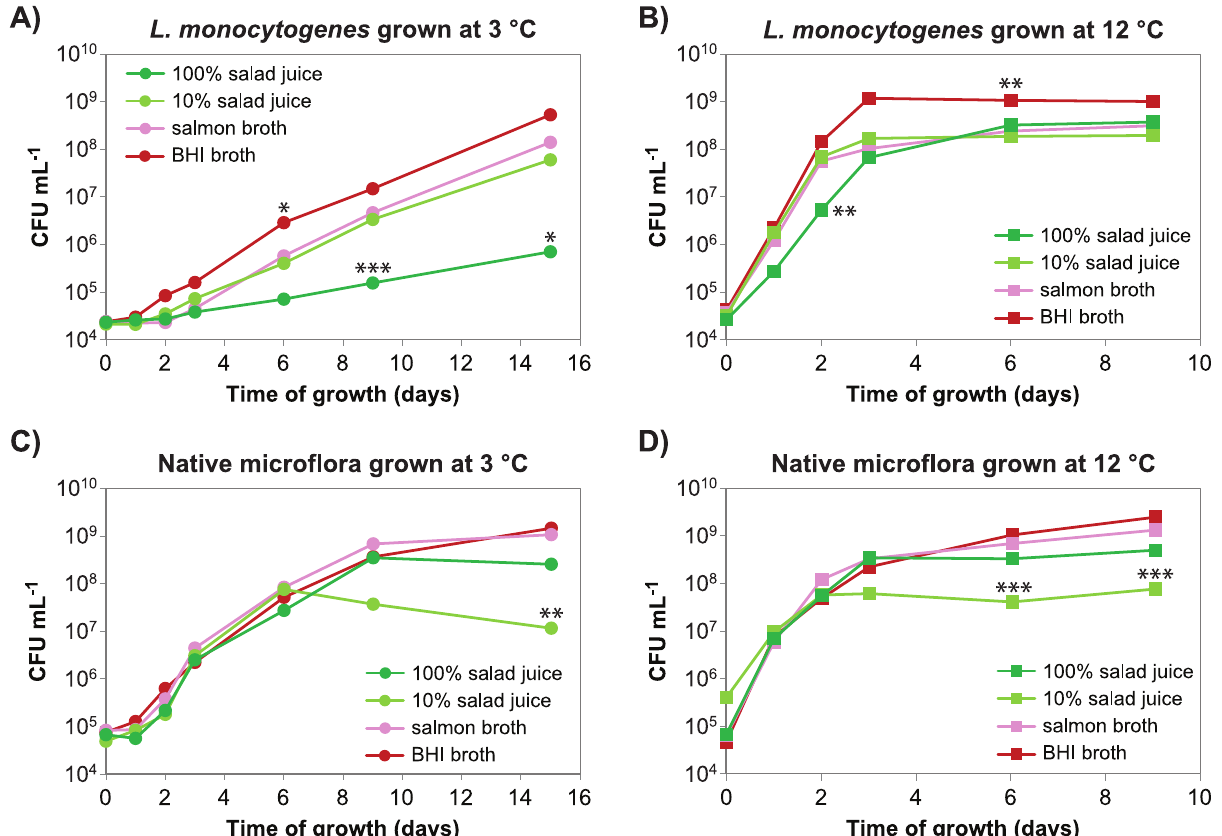
Fig 1. Salad juice inhibits growth of L . monocytogenes . The salad juice was prepared from a 1:4 (w/w) mixture of rocket salad and iceberg lettuce. Each growth curve represents growth of a mixture of four strains: A, B) L . monocytogenes strains MF1509, MF3638, MF2184 and MF3939. C, D) Pseudomonas isolates MF6122, MF6124, and MF6125, and Sphingomonas isolate MF6123. The temperatures during growth were A, C) 3˚C and B, D) 12˚C. The experiment was performed 2-3 times and averages from the two experiments with complete sampling series is shown. All three individual replicates are shown in S1 Fig. Asterisks indicates significant differences in log (CFU mL -1 ) between the marked sample and each of the three other cultures grown at the same temperature with the same mixture of bacteria and collected at the same time (Tukey’s post hoc test; � p < 0.05, �� p < 0.01, ��� p <